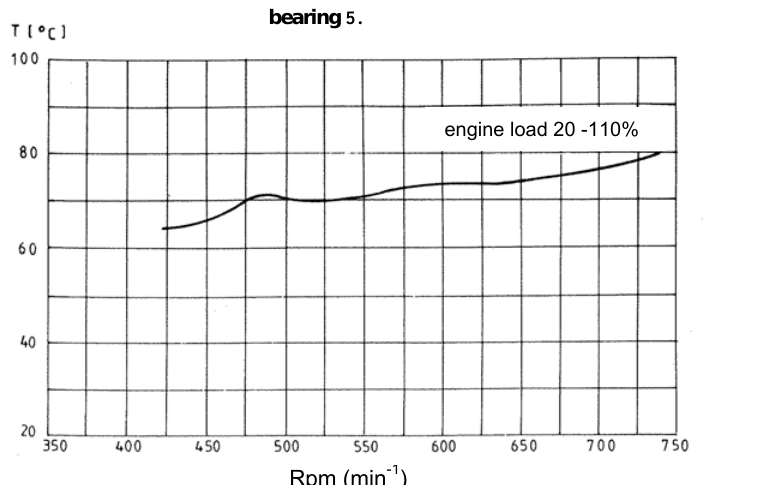
Figure 11 – Temperature change on the 5th main bearing depending on the engine load Рисунок 11 – Изменение температуры на 5- м главном подшипнике в зависимости от нагрузки двигателя Слика 11 – Промена температуре на 5. главном лежају зависно од оптерећења Figure 12 shows a scheme for measuring the vibration